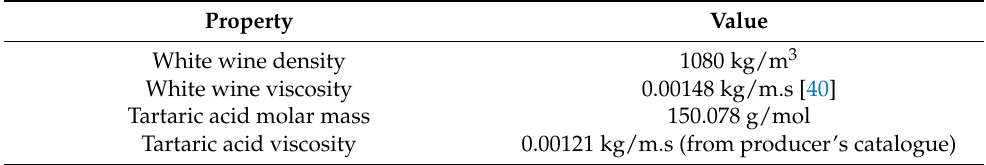
Table 3. Physical properties of white wine and tartaric acid at room temperature (25 ◦ C).